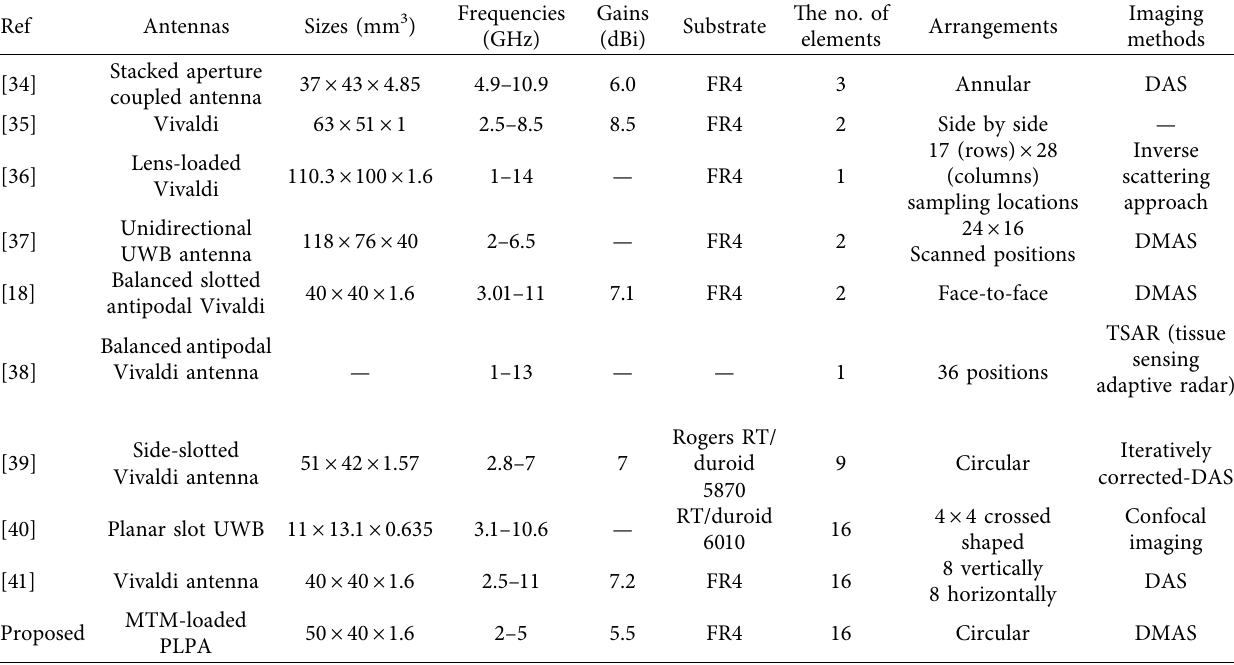
Table 1: Comparison of the proposed imaging system with other existing systems in the literature.